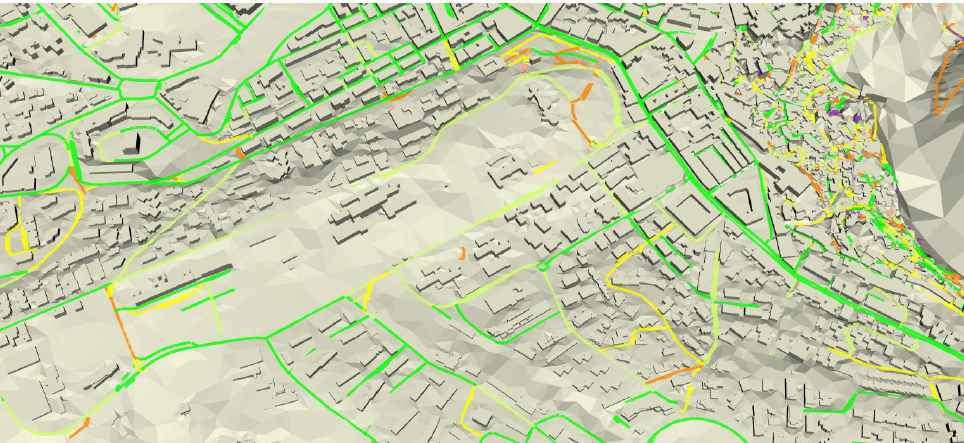
Figure 8. The road network is depicted according to the average slope (from green = null slope to red = 30°). Here the representation is smoother since an arc (between two branches) has an aggregated slope value.